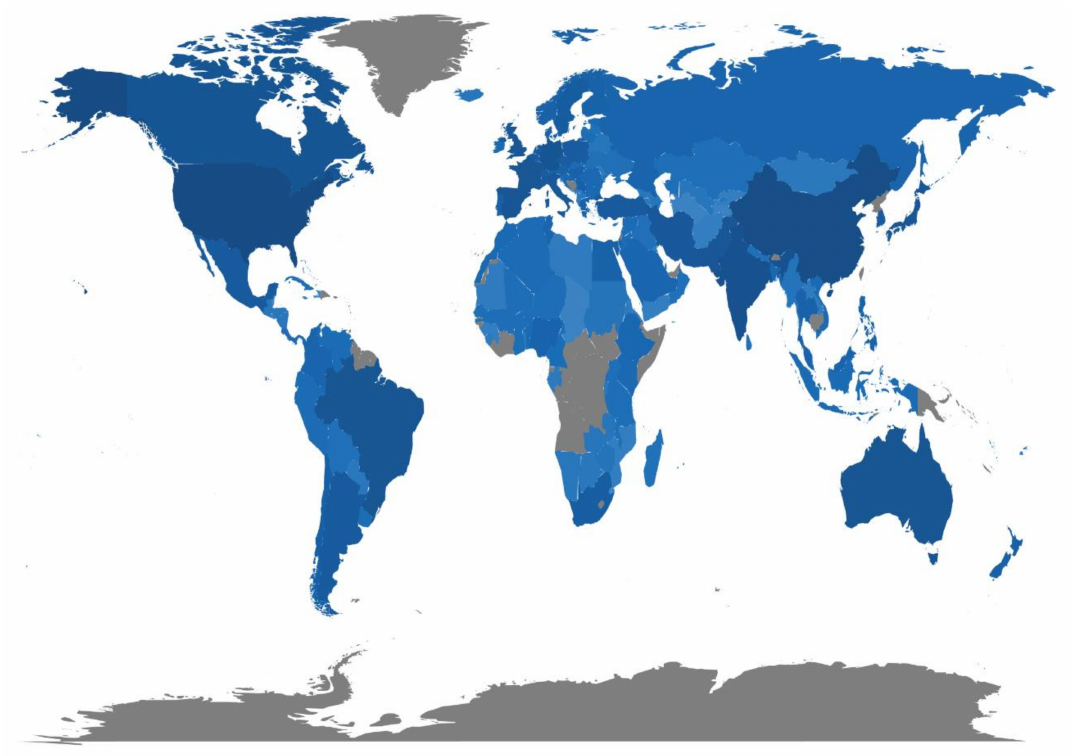
Figure 3. Country scientific production. The color intensity is proportional to the number of publica- tions in ST studies.